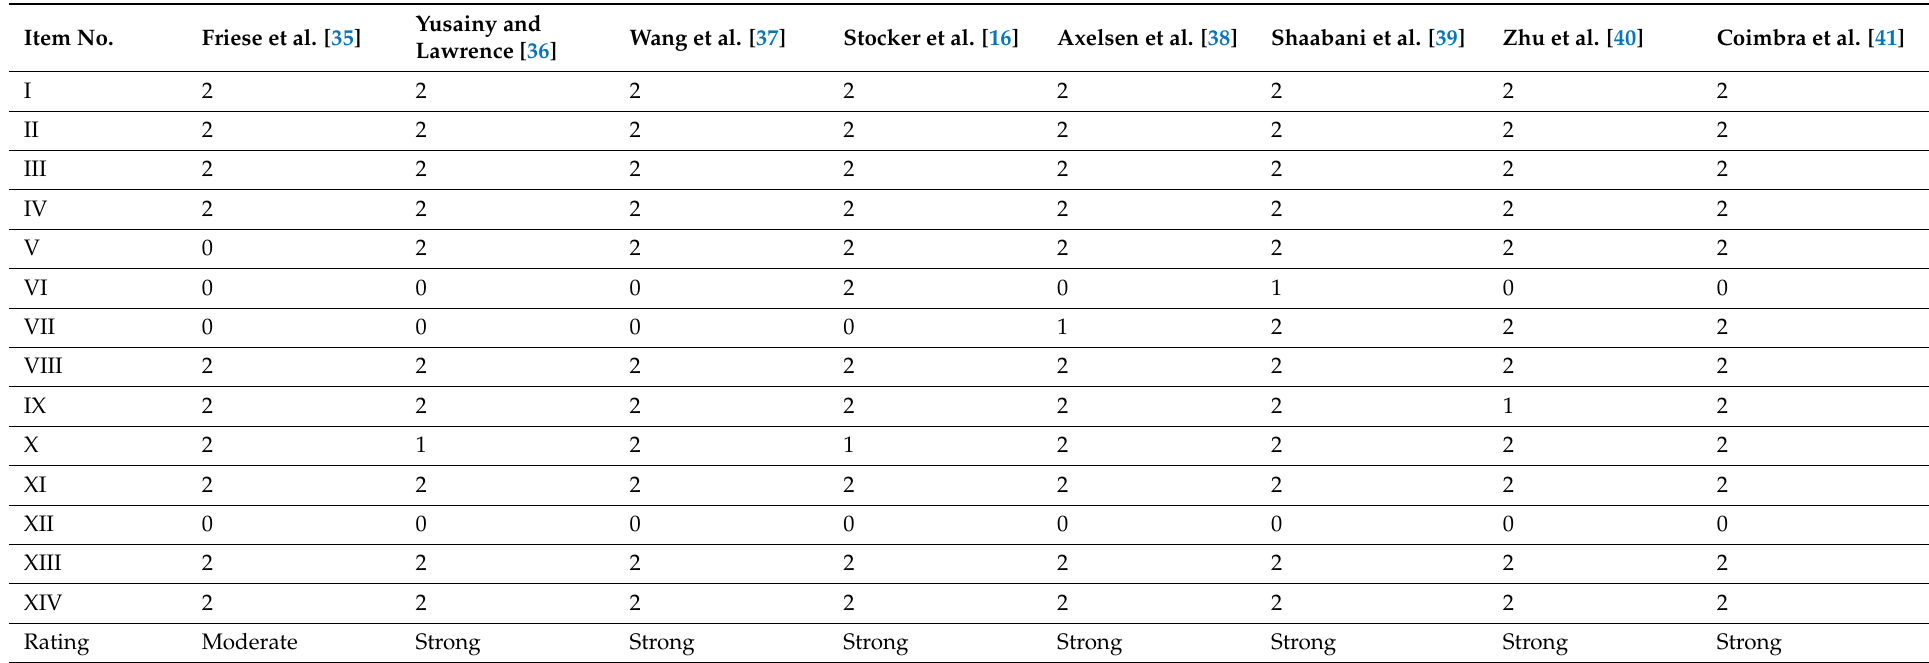
Table 3. Quality assessment through